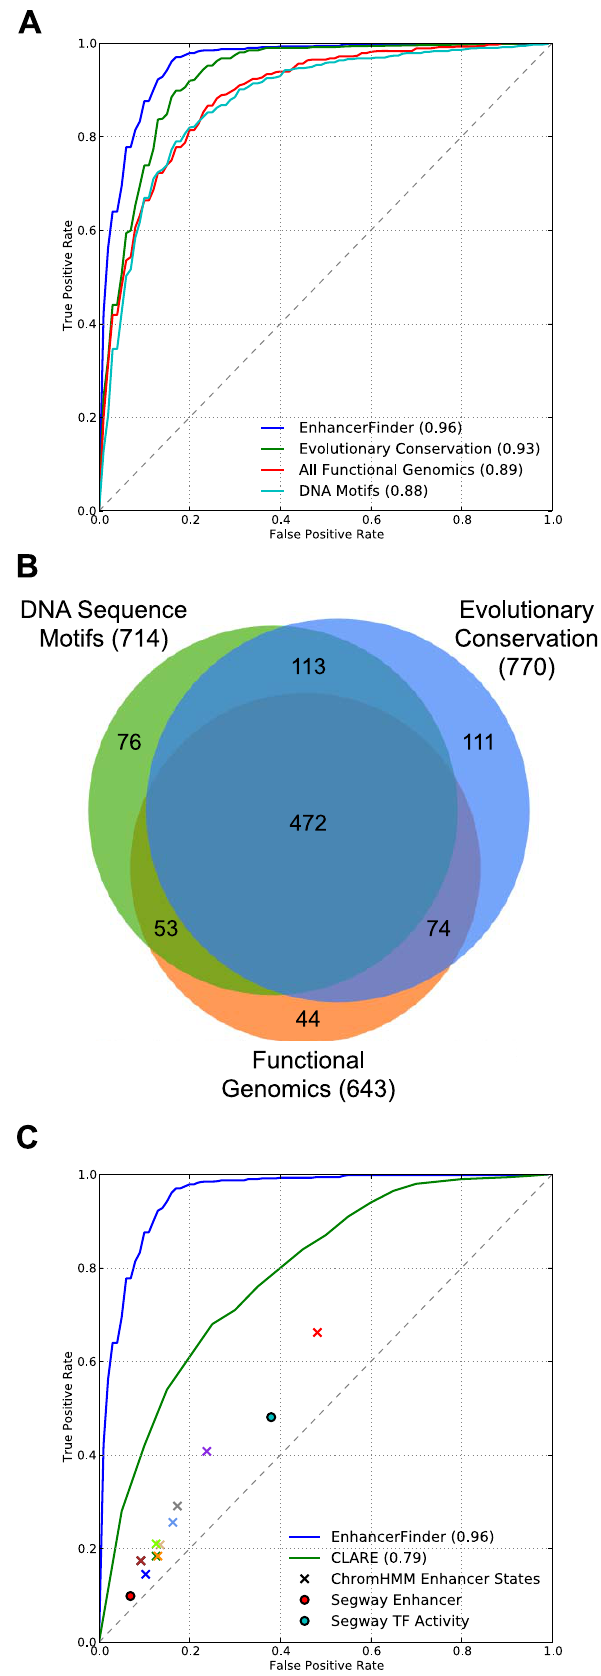
Figure 2. Combining diverse data using EnhancerFinder improves the identification of developmental enhancers. (A) Enhancer prediction strategies based on functional genomics data, evolutionary conservation, and DNA sequence motif patterns all perform well, but EnhancerFinder, which combines these data, provides significant improvement over each of them alone (p , 2.0E-7 for all). (B) Each of the approaches from (A) predicts that somewhat different sets of the VISTA regions are enhancers. This suggests that complementary information is contained in each data source. EnhancerFinder (not shown), which combines them, captures many of the enhancers that are unique to each source; it predicts 25 of the 44 enhancers unique to Functional Genomics , 30 of the 76 unique to DNA Sequence Motifs , and 34 of the 111 unique to Evolutionary Conservation . (C) EnhancerFinder outperforms CLARE, a successful enhancer prediction method based on known regulatory motifs. We also evaluated the enhancer states predicted by ChromHMM and Segway, two unsuper- vised clustering methods that have been used to segment the genome into different functional states based on patterns in functional genomics data, though these methods were not applied to develop- mental contexts. The different X’s represent state predictions based on data from different ENCODE cell types: GM12878 (blue), H1-hESC (violet), HepG2 (brown), HMEC (tan), HSMM (gray), HUVEC (light green), K562 (green), NHEK (orange), NHLF (light blue), and all contexts combined